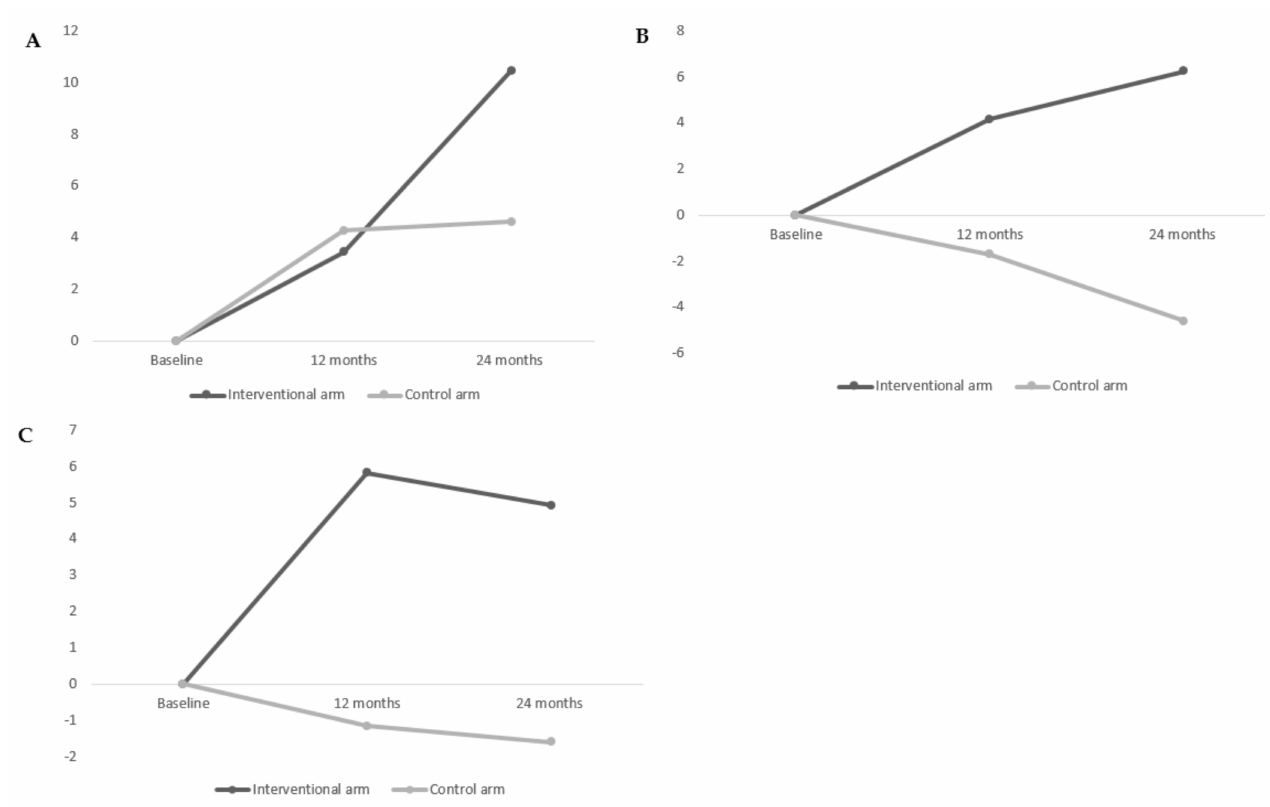
Figure 2. Evolution of difference of scores (with respect to baseline scores), ( A ) EQ VAS, ( B ) satisfaction with waiting times, and ( C ) satisfaction with accessibility between both